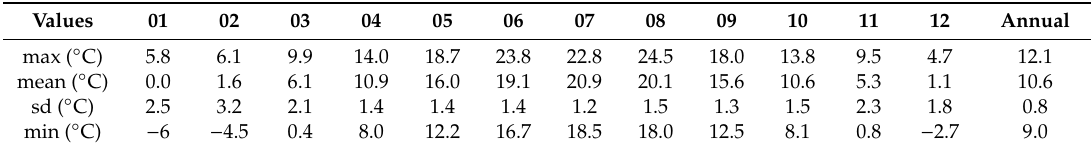
Table 1. Monthly and annual average air temperature in Varaždin. Statistics in rows refer to maximum, mean, and minimum average monthly and annual temperature in the 1981–2010 period, and the standard deviation (sd).